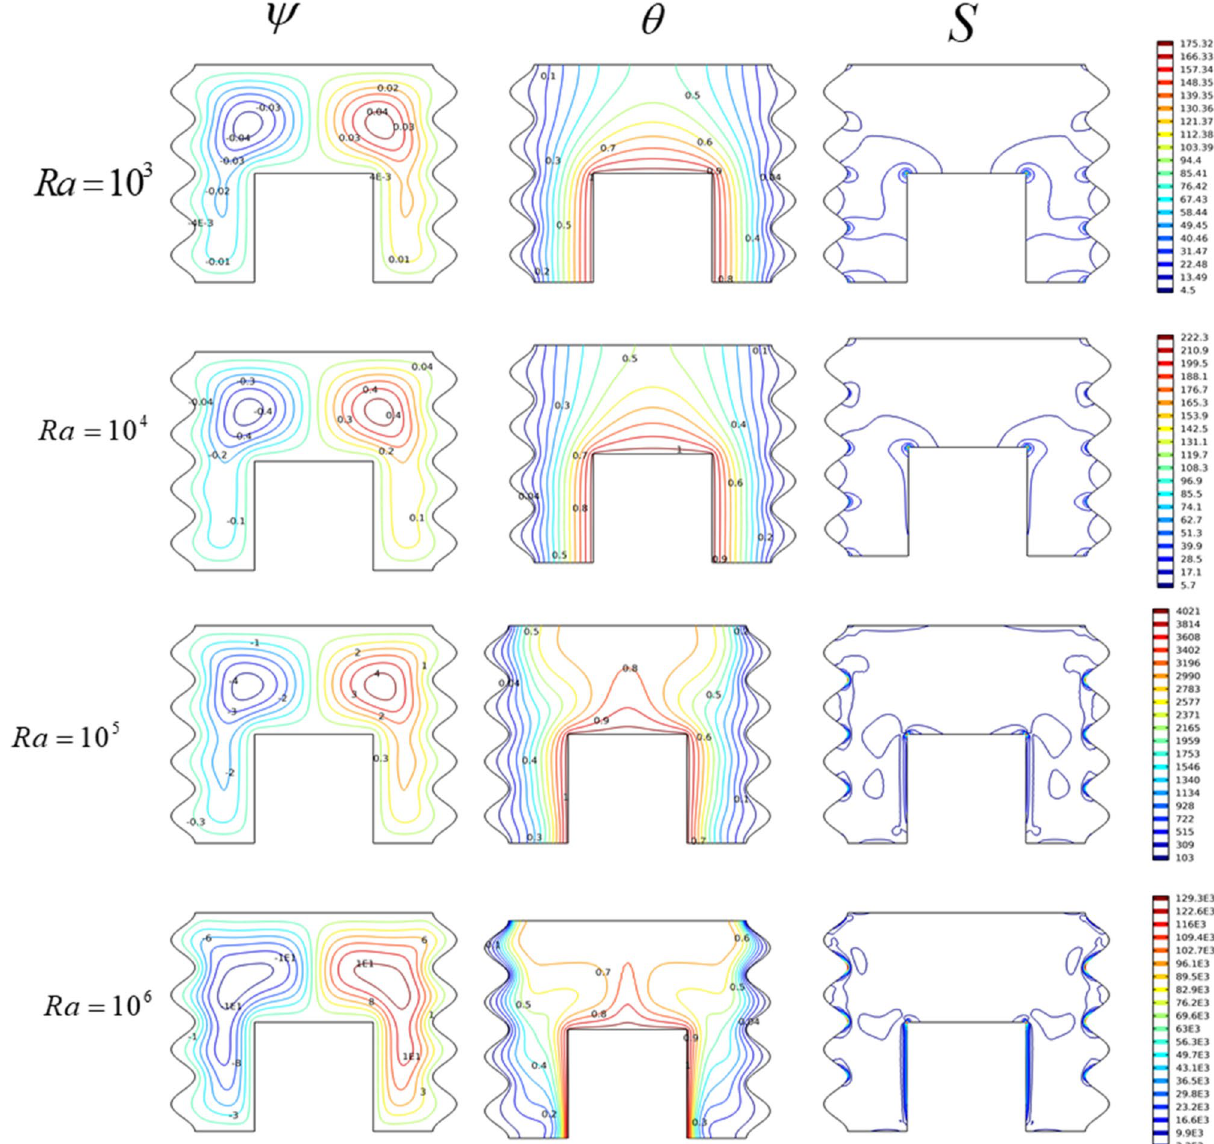
Figure 3. The impact of Ra on (ψ) Streamlines, (θ) Isotherms, and (S) Entropy for Da = 10 –2 , Ha =